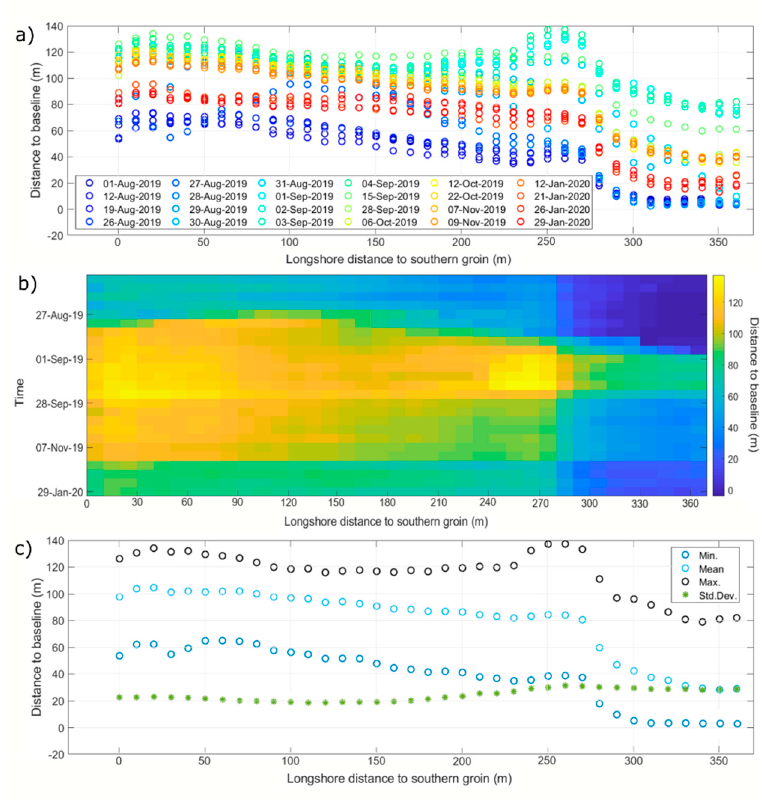
Figure 7. Shoreline position evolution. ( a ) Shoreline evolution through the monitoring period (August–January); ( b ) time-space image displaying the shoreline evolution: rows indicate the date of Timex used for the shoreline detection, columns represent the longshore distance (space) from the southern limit of the beach, color represents the beach width; ( c ) the minimum, mean, maximum, and standard deviation values of distance to baseline/beach extension, during the monitored period.